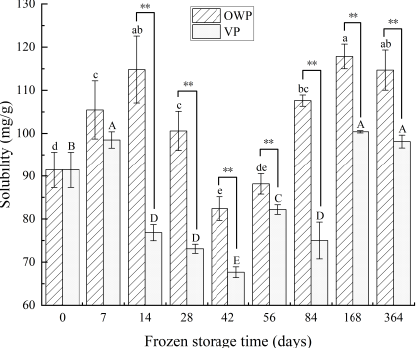
Figure 2. Changes in solubility of yak rumen SMP during frozen storage. Different superscript let- ters in the figure indicate significant difference in storage time ( p < 0.05); lowercase letters are for OWP and uppercase letters for VP. “*” indicates that the different packag ing is significant ( p < 0.05), and “**” indicates that the differen t packaging is extremely significant ( p < 0.01).